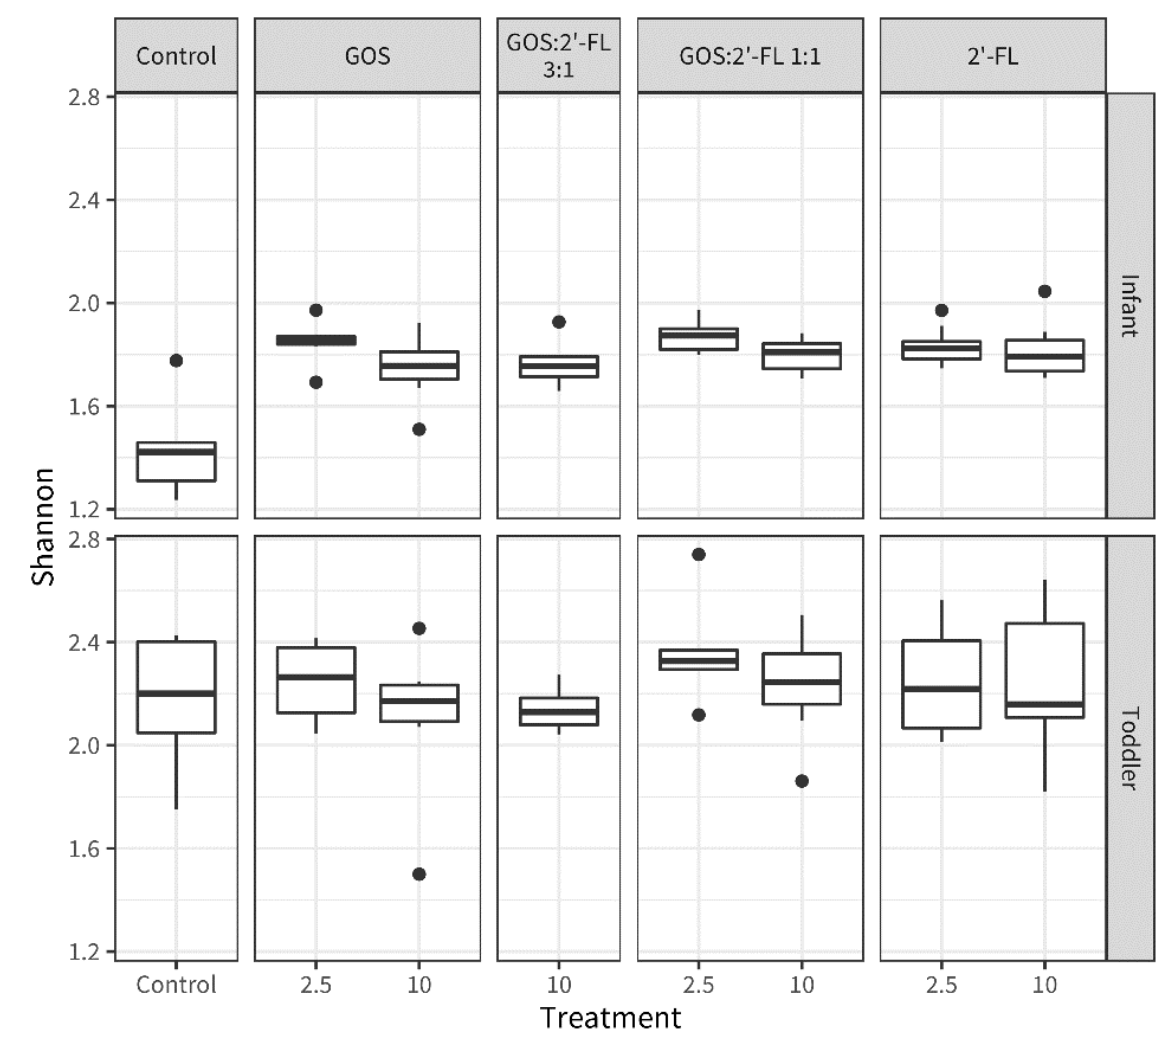
Figure 1. Boxplots representing the Shannon alpha diversity of the samples from the micro-Matrix bioreactor batch fermentations with fecal pools from infants (top) and toddlers (bottom) after 6 h of fermentation with GOS, 2′ -FL, or mixtures thereof (GOS: 2′ -FL 3:1 and 1:1) at concentrations of 2.5 and 10 g/L, or without oligosaccharide (control). The boxes represent the interquartile ranges, thick vertical lines represent sample medians, the upper whisker ranges from the largest value within 1.5 × IQR (Interquartile range) from the hinge and the lower whisker ranges to the smallest value within 1.5 × IQR from the hinge.